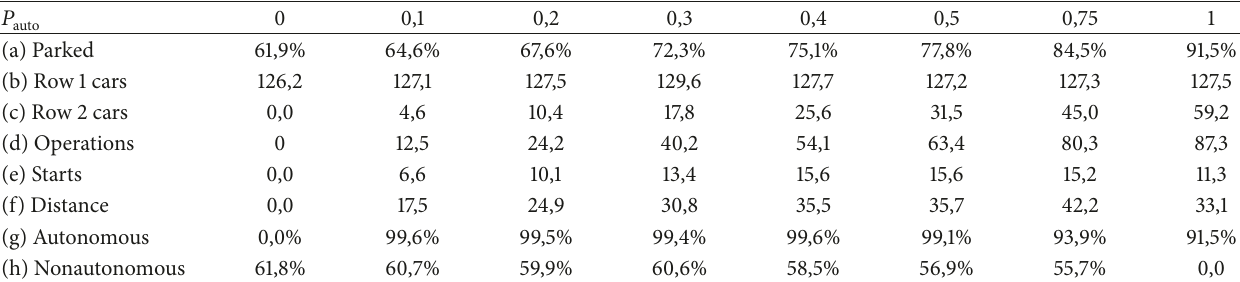
Table 2: Results, first scenario, 204 vehicles.